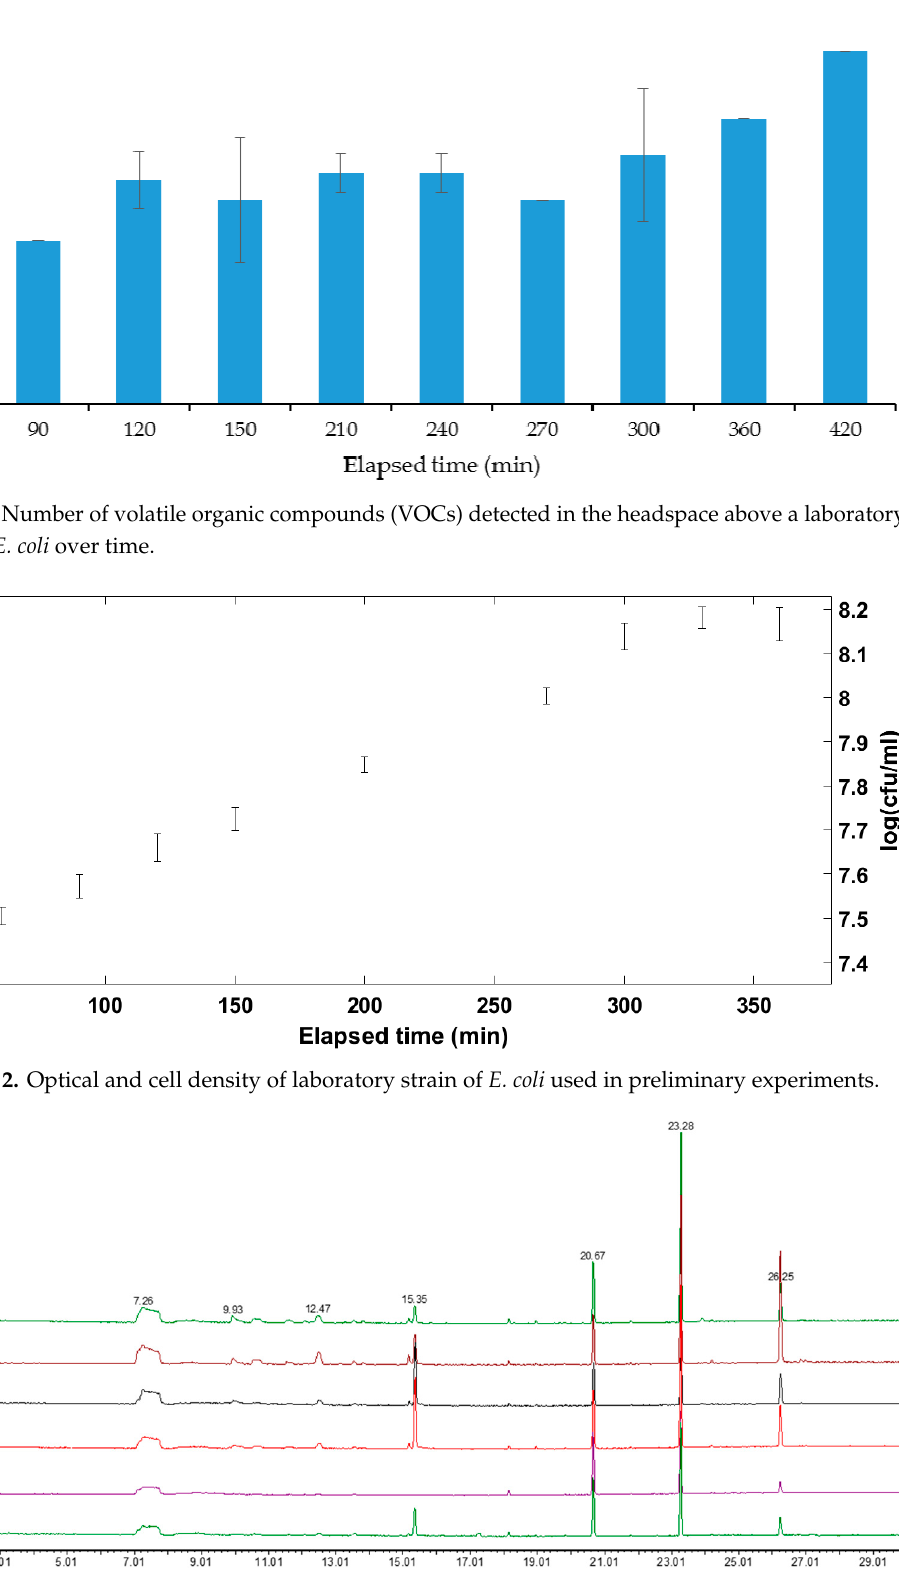
Figure 3. The chromatograms showing the increase of the VOCs with the increasing time of the incubation, up to 300 min.